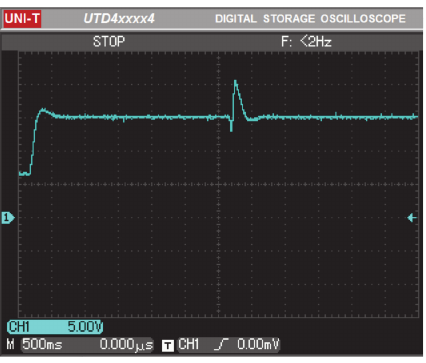
Figure 10: Experimental results: oscilloscope response to the output voltage V 𝑜 (𝑡) of the new controller